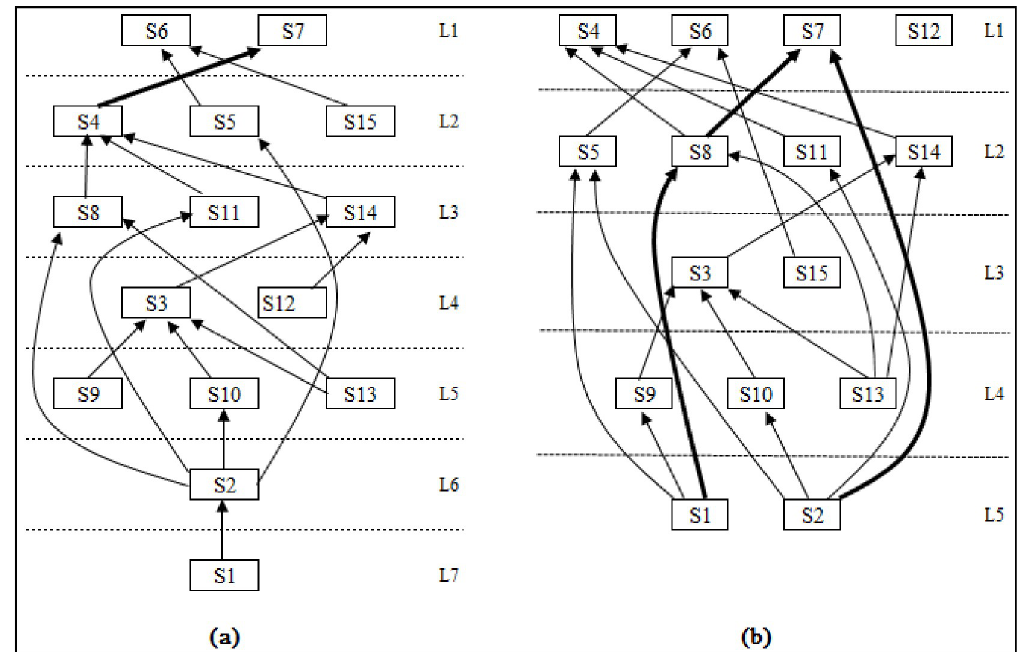
Fig 3. Factor layers and inner influence relationships of two